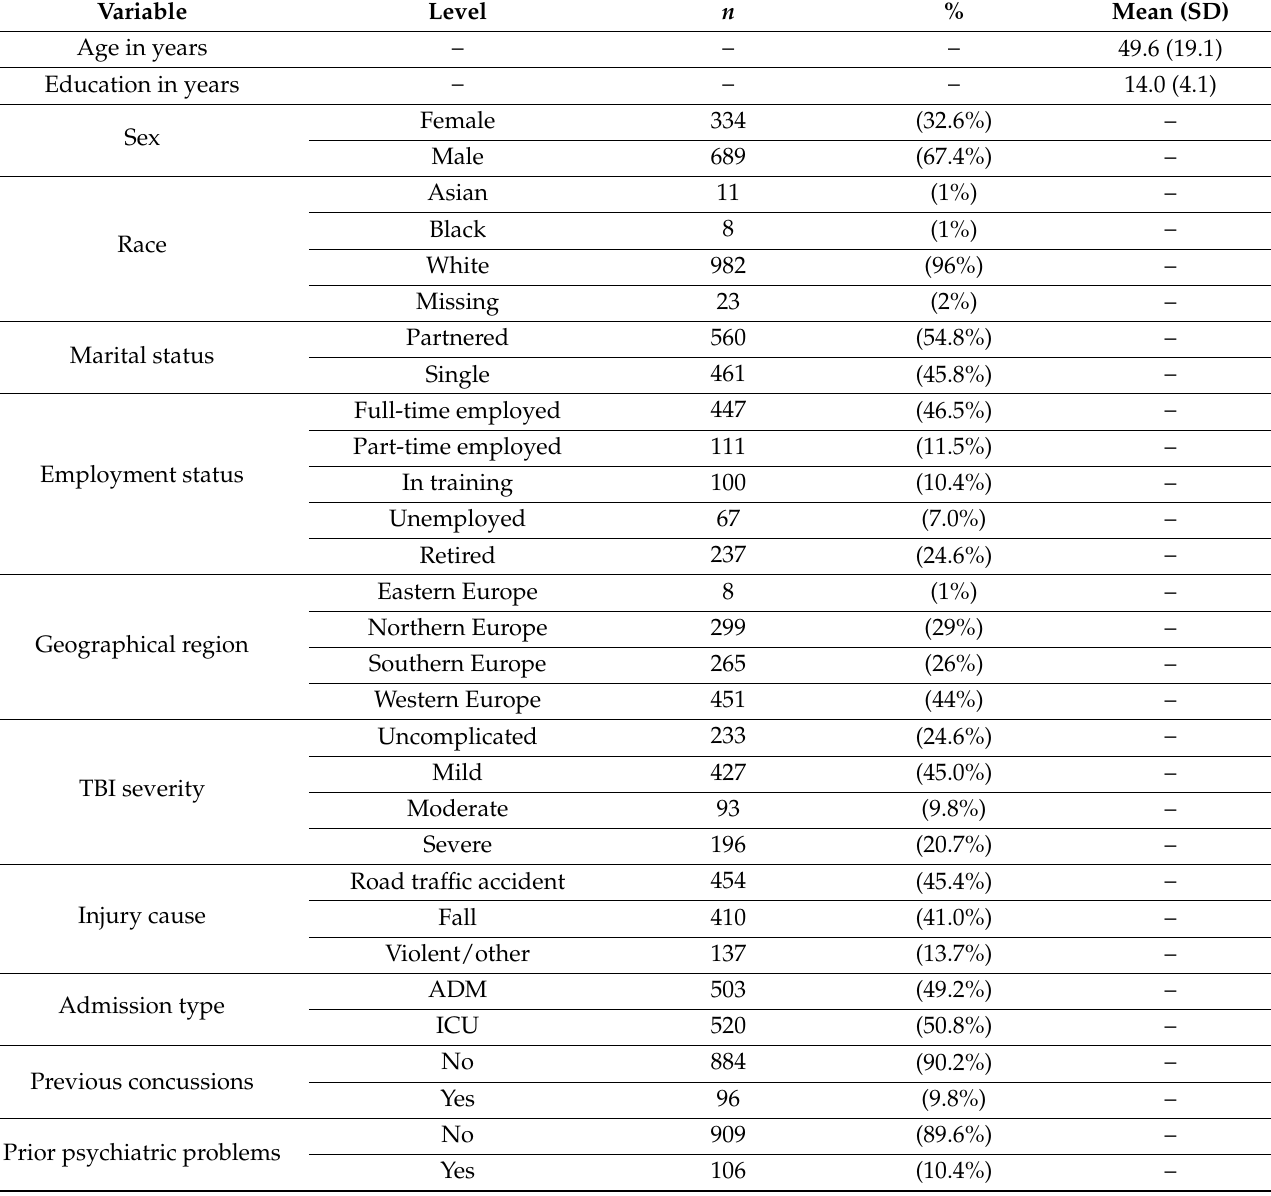
Table 1. Demographic characteristics of the